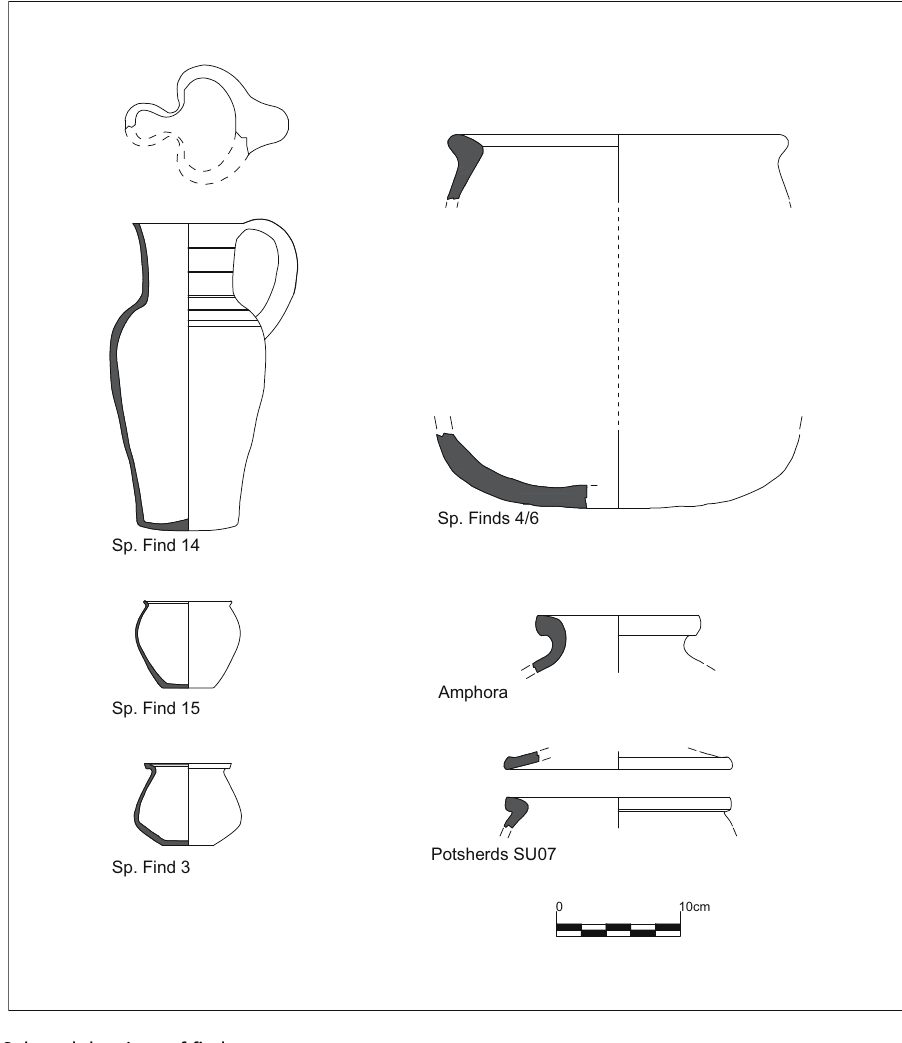
Figure 12: Selected drawings of fi